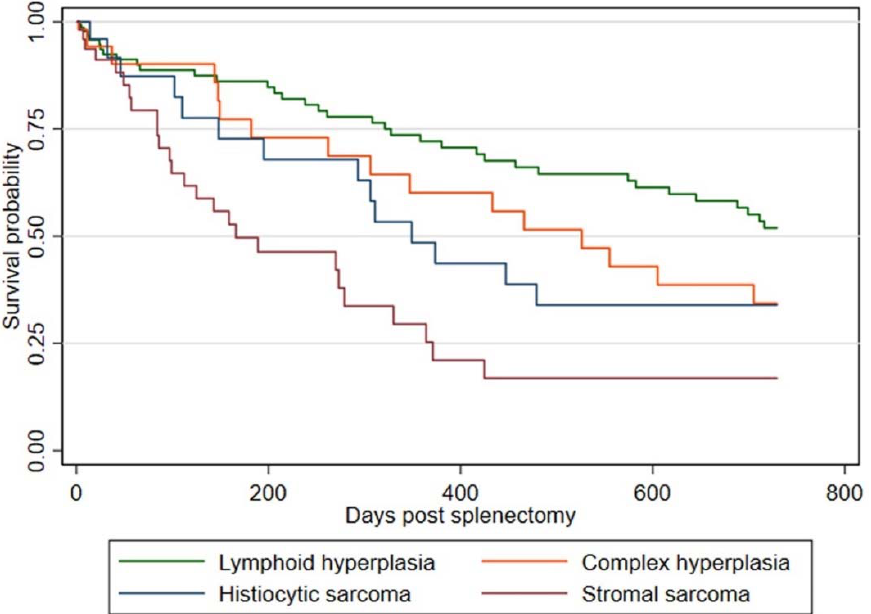
Figure 2. Kaplan-Meier Curve for 2-year post-splenectomy survival for each type of fibrohistiocytic nodule among dogs identified from the VetCompass Australia database that attended primary-care veterinary clinics during 1989–2018 in Australia. Table 5. Results from Cox proportional hazard model estimating the associations between type of splenic fibrohistiocytic nodule, age, sex, and breed on survival of dogs identified from the VetCom ‐ pass Australia database that attended primary ‐ care veterinary clinics during 1989–2018 in Australia.